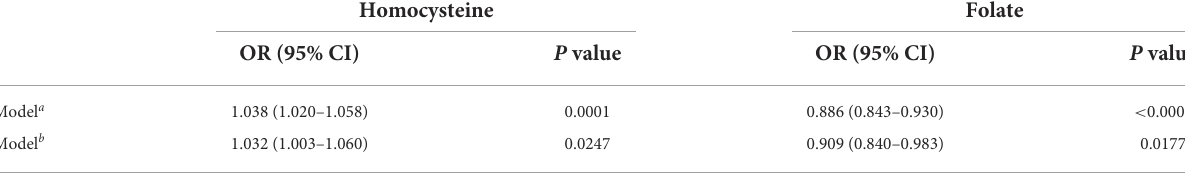
TABLE 2 Adjusted ORs for T2DM incidence according to homocysteine and folate concentrations.